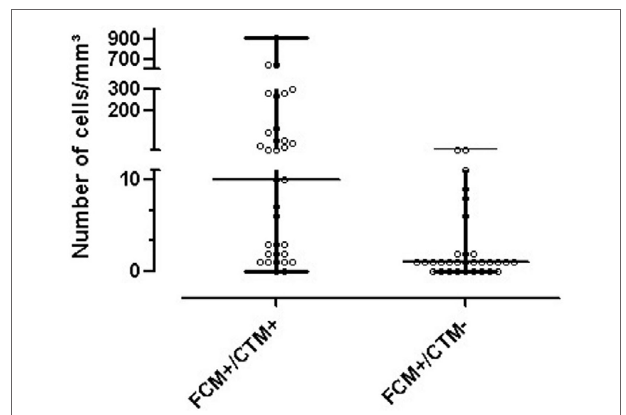
FigUre 6 | Positive results for flow cytometry and results found for